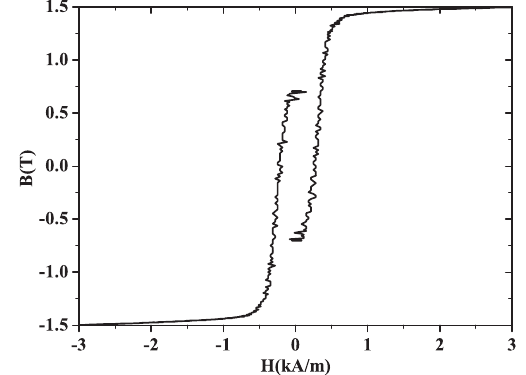
FIG. 6. B-H loop of the No. 2 magnetic core. The breakdown voltage of the gas switch is about 16.2 kV. The amplitude of the induced voltage pulse across the magnetic core is 10.4 kV, and the pulse duration is 1 . 4 μ s before the magnetic core saturates.